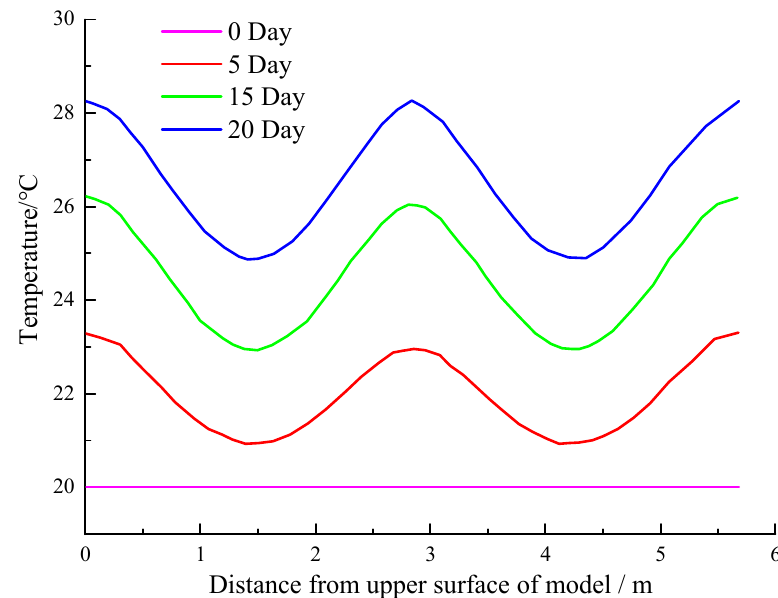
Figure 25. The temperature distribution curve of the longitudinal section line.